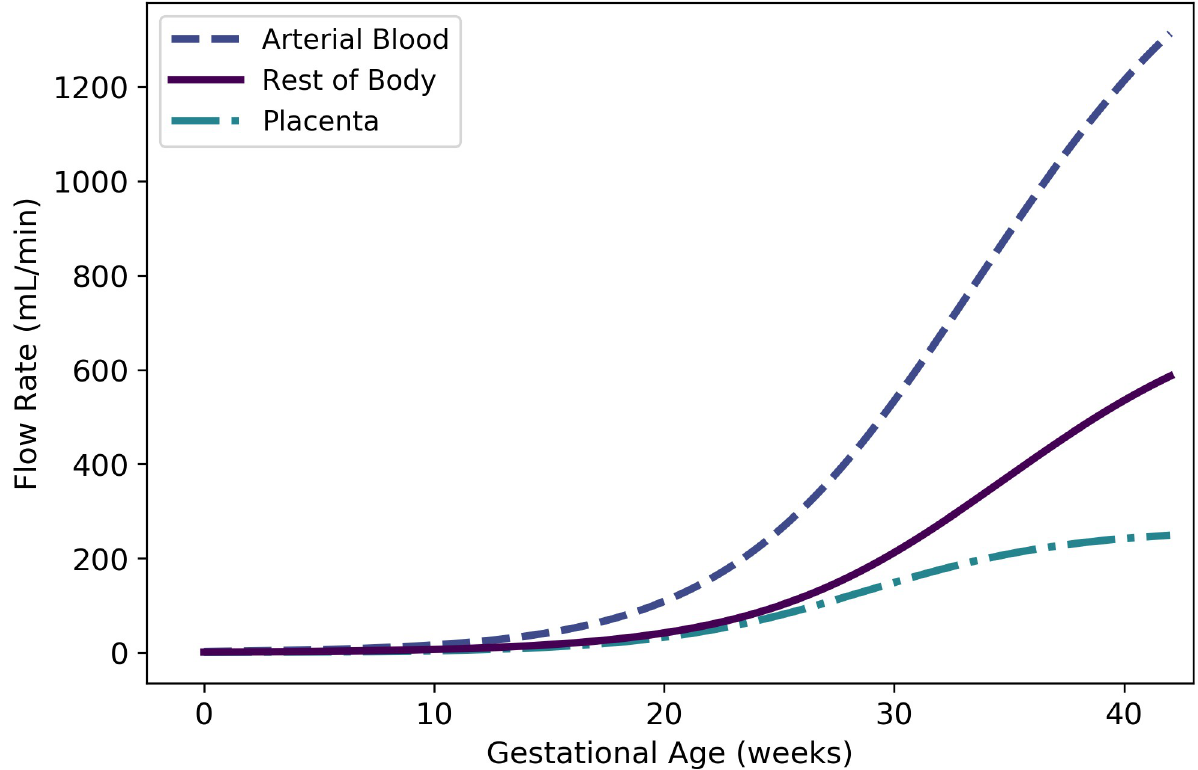
Fig 28. Fetal blood flow to the “rest of body” compartment vs. gestational age (cf. Eq 57). Fetal blood flow to the arterial blood compartment (cf. Eq 47) and the placenta (cf. Eq 50) are shown for comparison.